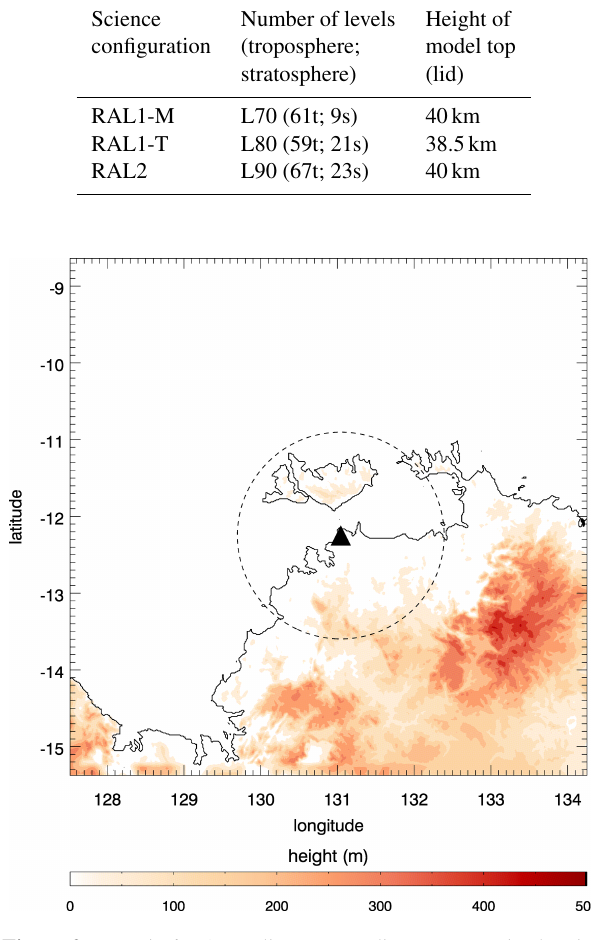
Figure 2. Domain for Australian case studies over Darwin showing the Top End of Australia’s Northern Territory (which includes Dar- win) and the Tiwi Islands. The C-band polarisation (CPOL) radar location is denoted by the black triangle and its coverage by the area within the circle of dashed lines, which is the area used for the analysis presented in Fig.